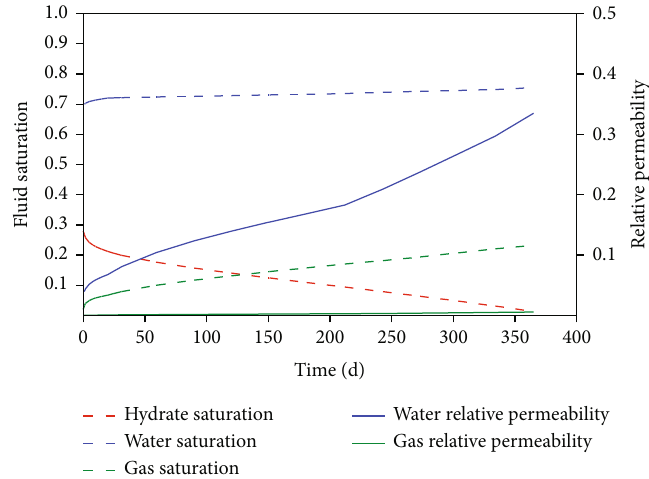
Figure 17: The variations of the water and gas relative permeability 5m from the well.